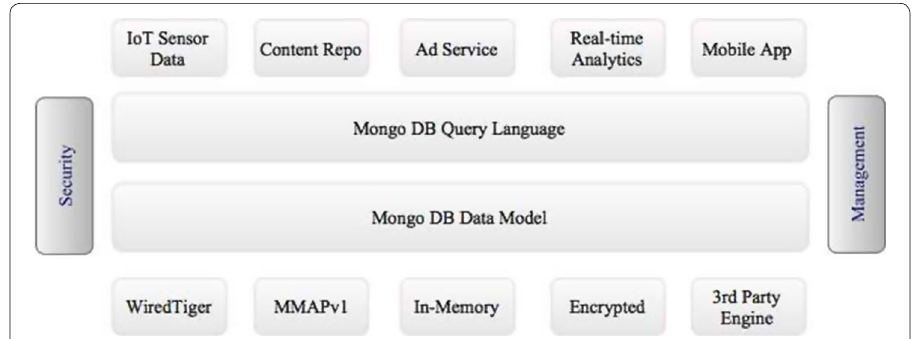
Fig. 2 Flexible storage architecture, optimising MongoDB for unique application demands